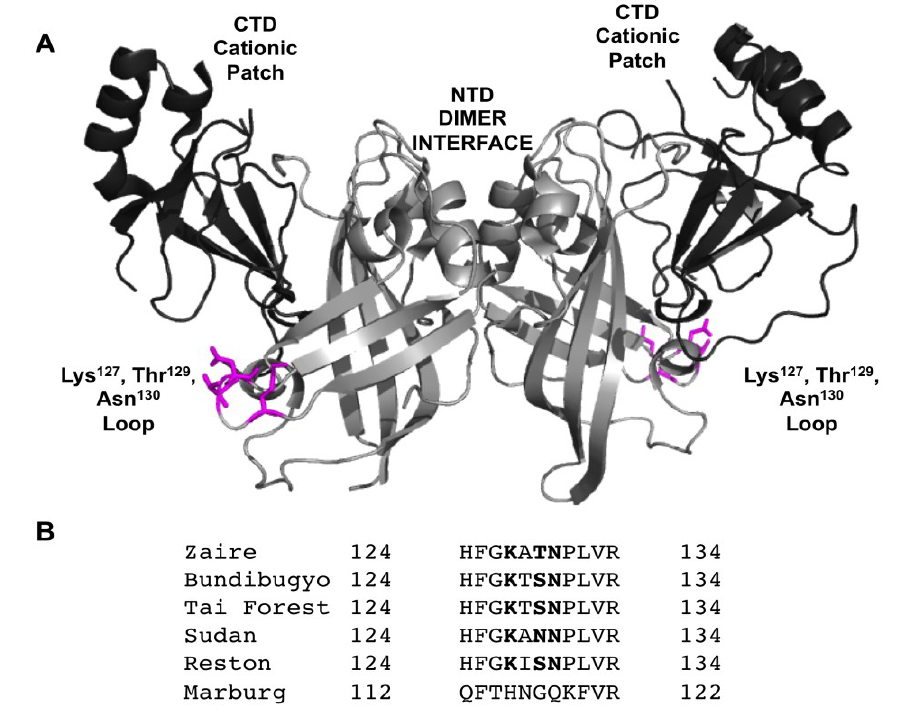
Figure 1. VP40 harbors a N-terminal and C-terminal domain. ( A ) VP40 (PDB ID: 4LDB) is a dimer mediated by a N-terminal domain (NTD) interface. The C-terminal domain (CTD) mediates membrane binding through a cationic patch and also creates an